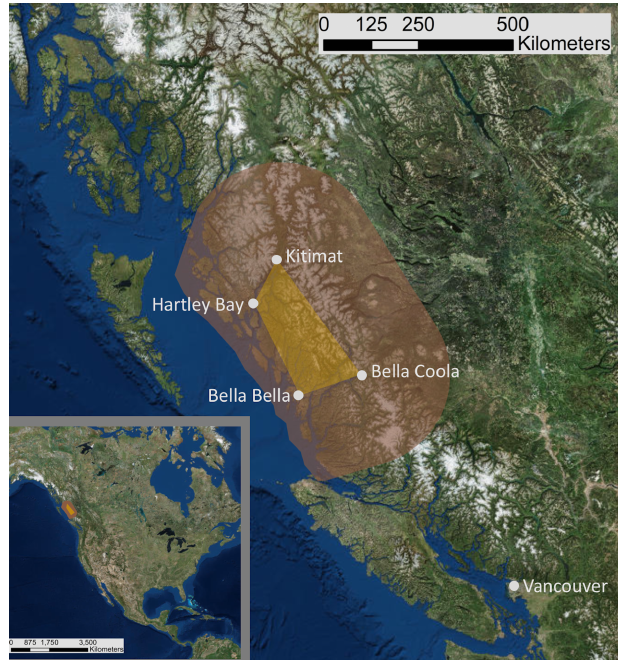
Fig. 1. Map of the study area. The study area parallelogram (yellow), which contains all samples ( N = 147), on background map (Google Earth Pro version 7.3) is bounded by Kitimat, Hartley Bay, Bella Bella, and Bella Coola, with a 200-km buffer (brown), excluding open ocean, for the creation of resistance surfaces. The inset map situates study area and buffer within North